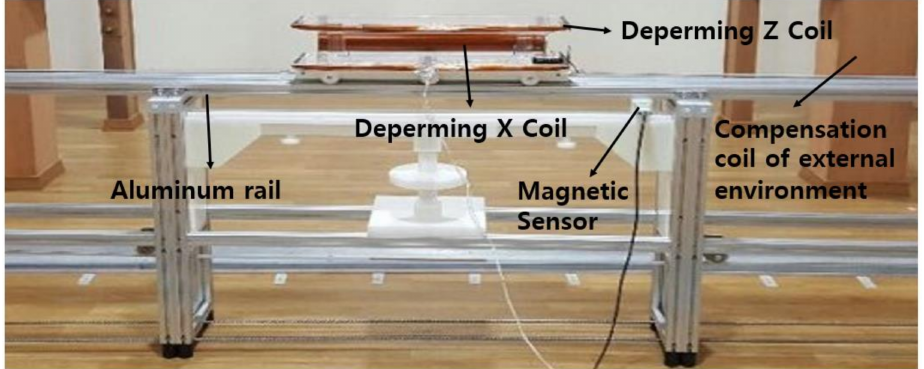
Figure 14. Experimental devices for the demagnetization.